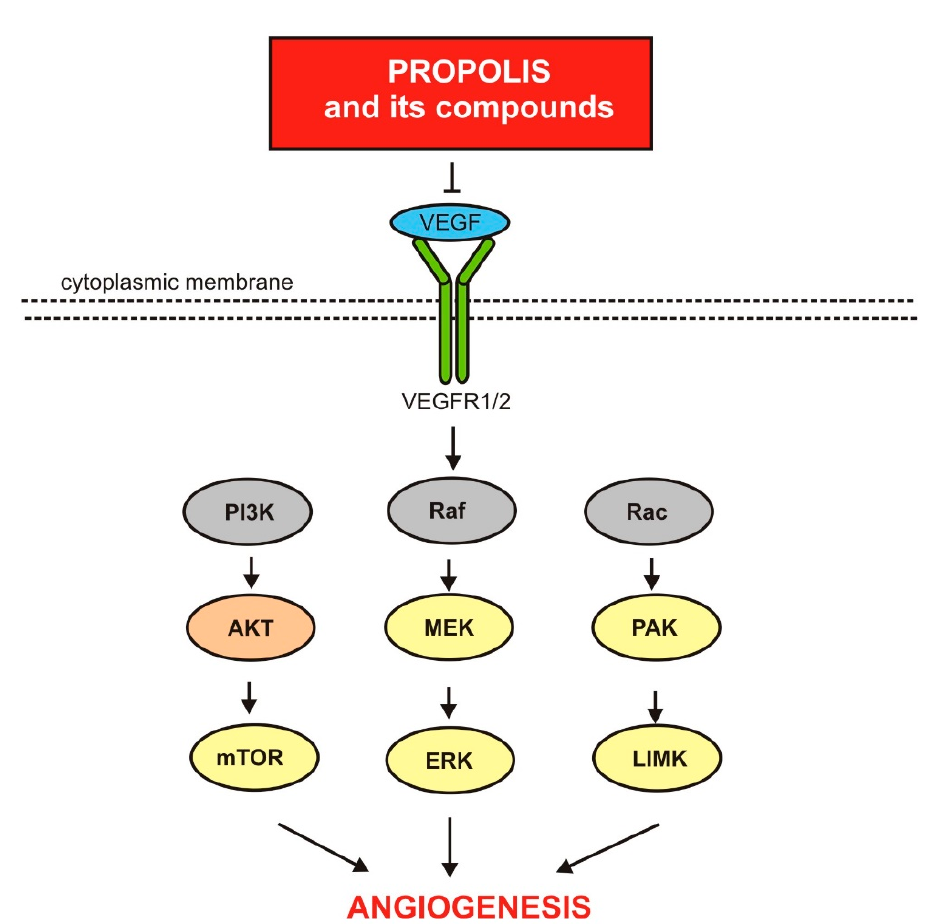
Figure 3. Anti-angiogenic activity of propolis and its compounds.